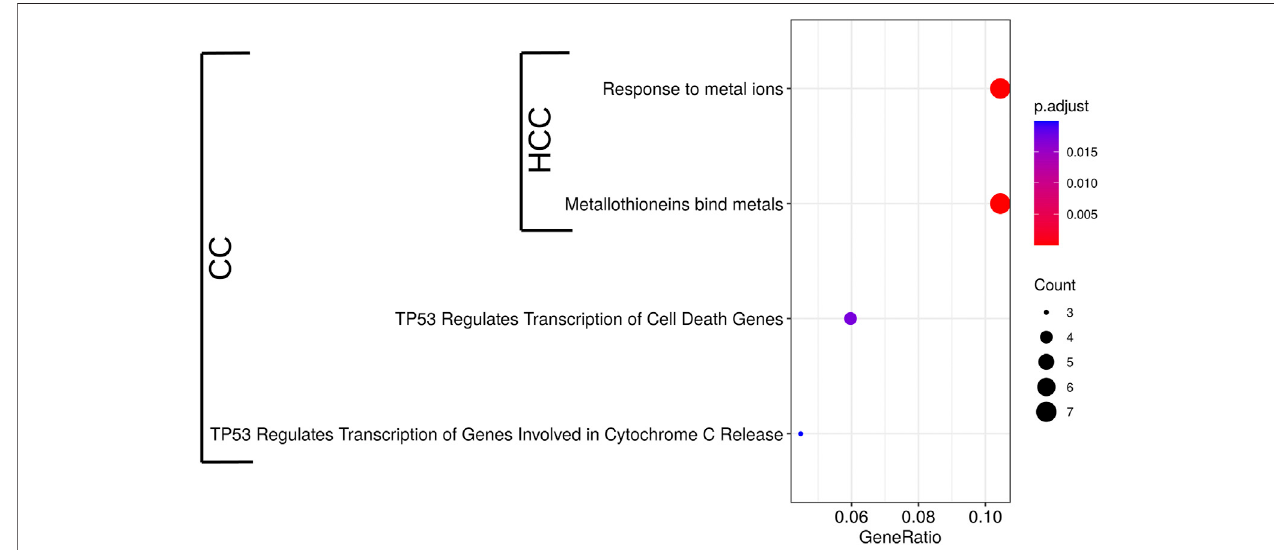
FIGURE 3 | Signi fi cant Reactome PA pathways up-regulated by 10 µM CC and HCC in HepG2 cells after 24 h. Induced pathways identi fi ed in the microarrays analysis were used to perform a pathway enrichment analysis. Pathways signi fi cantly enriched are shown ( p < 0.05, n (cid:2) 3). The circle diameter is proportional to the number of induced genes detected for each pathway, and the gene ratio is the proportion of genes in the whole pathway induced by the treatment.